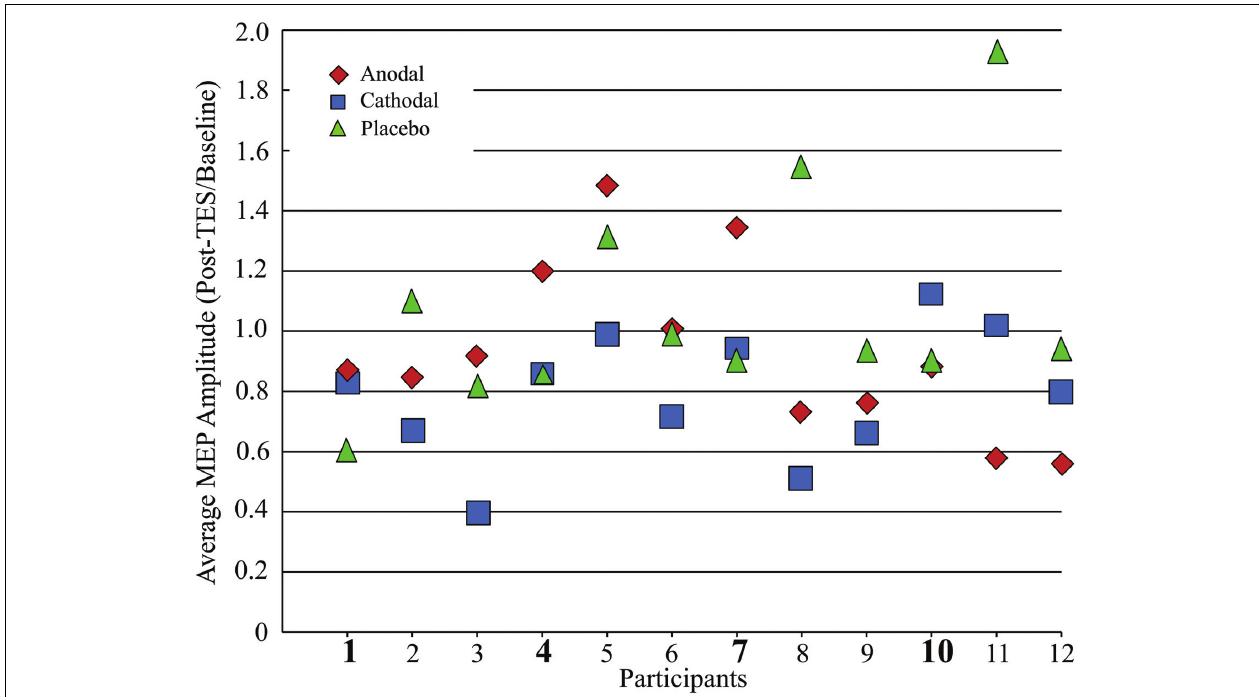
FIGURE 4 | Average MEP amplitude changes after tPCS plot for all 12 participants. Participant numbers in bold highlight those participants with cathodal MEP amplitudes equal to or greater than placebo MEP amplitudes.